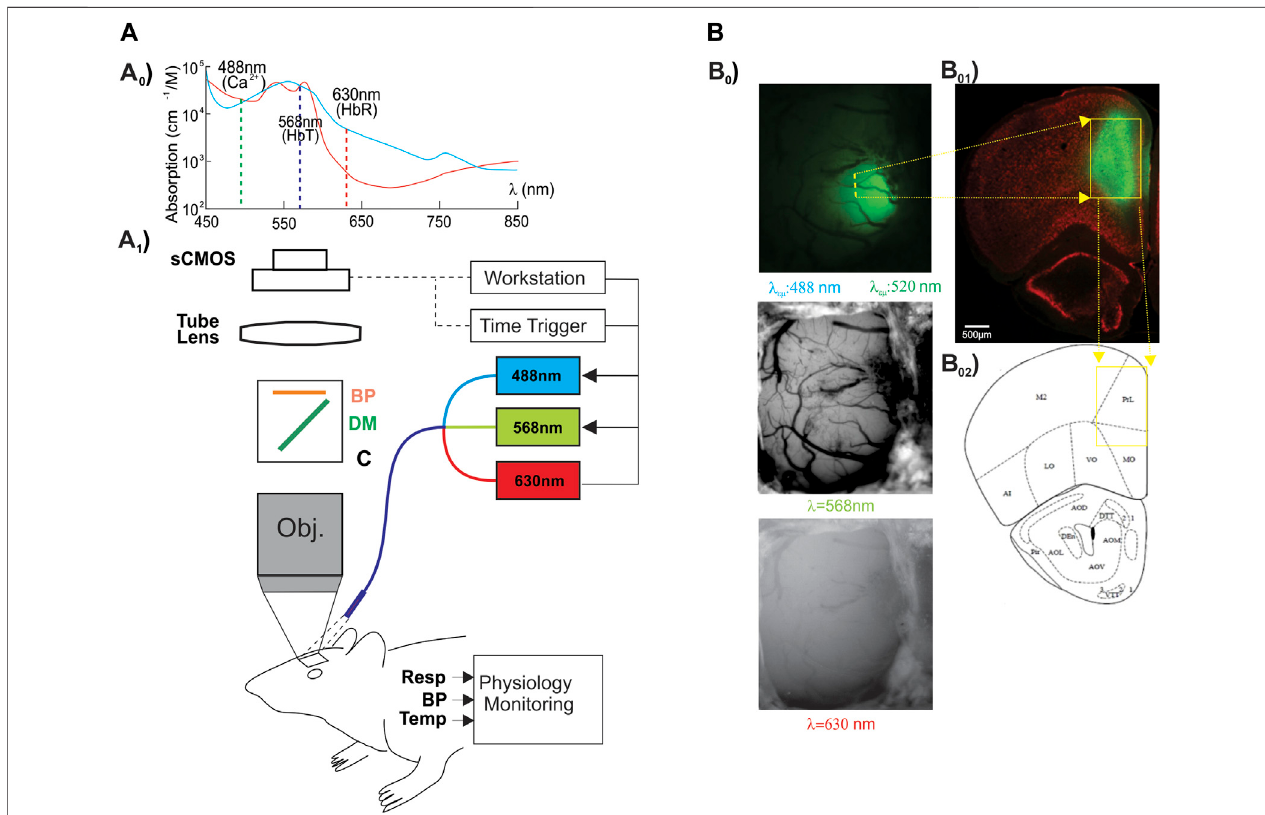
Results administration referring